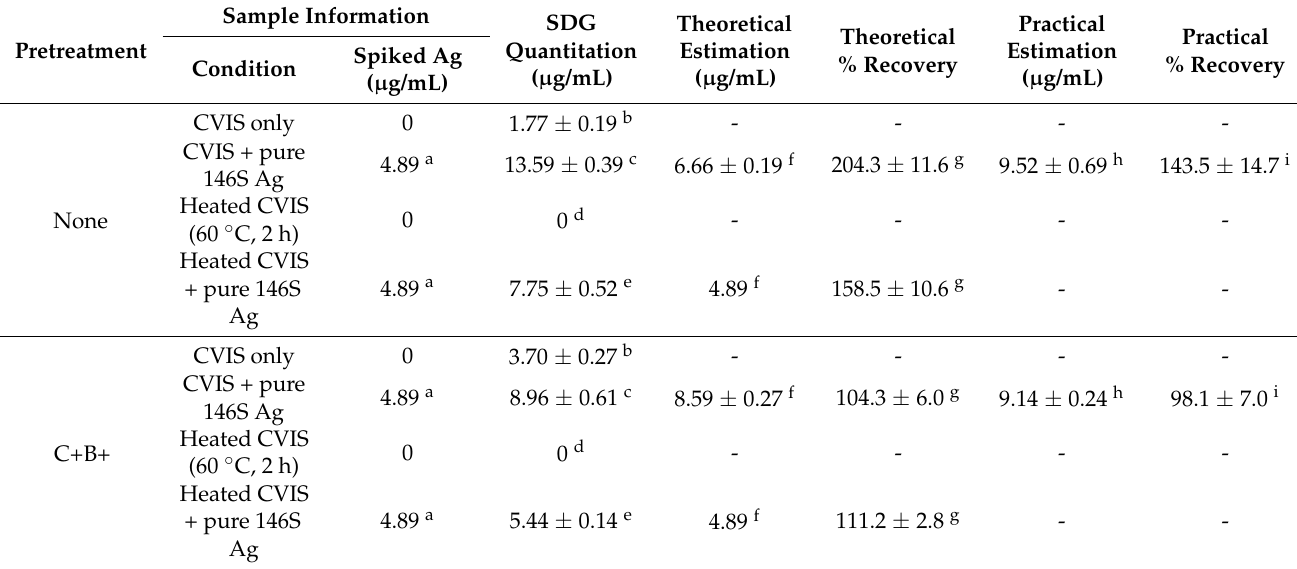
Table 1. A spiking test result by SDG ultracentrifugation for the validation of the pretreatment method for CVIS.